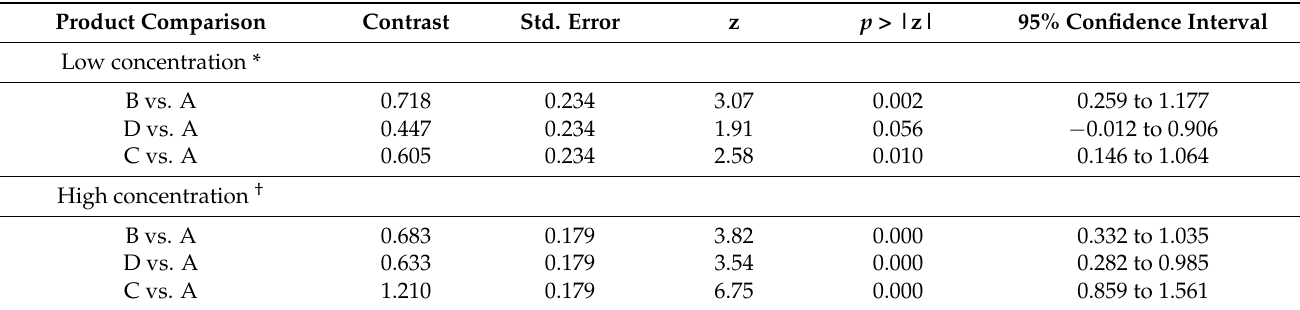
Table 5. ANOVA predicted difference (contrast) in mean log 10 Salmonella counts for all products at low and high concentra- tions against product A.